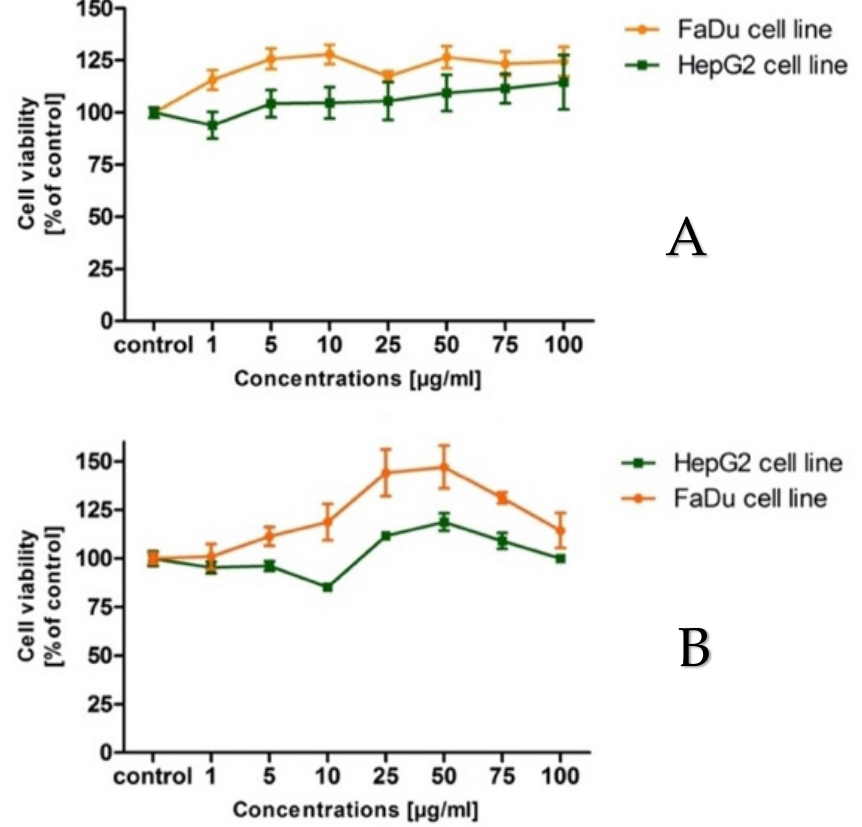
Figure 1. The cytotoxic activity of the samples towards FaDu and HepG2 cell lines. ( A ) cell viabilities with the intractum; ( B ) cell viabilities with the extract. Extract concentration 1, 5, 10, 25, 50, 75, 100 µg/mL.